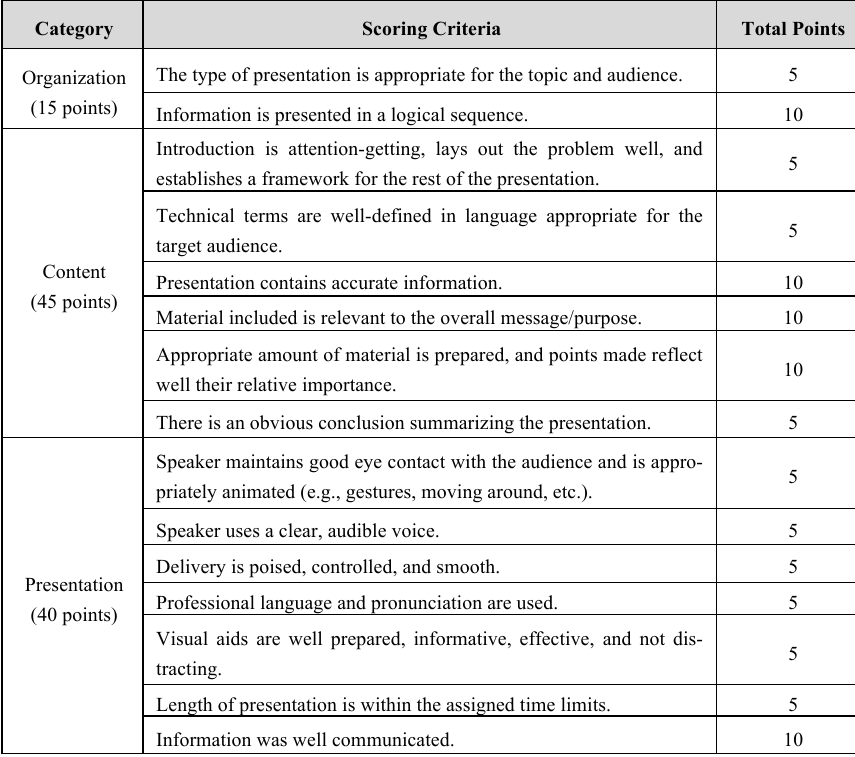
Table 2. Marking criteria for oral presentations